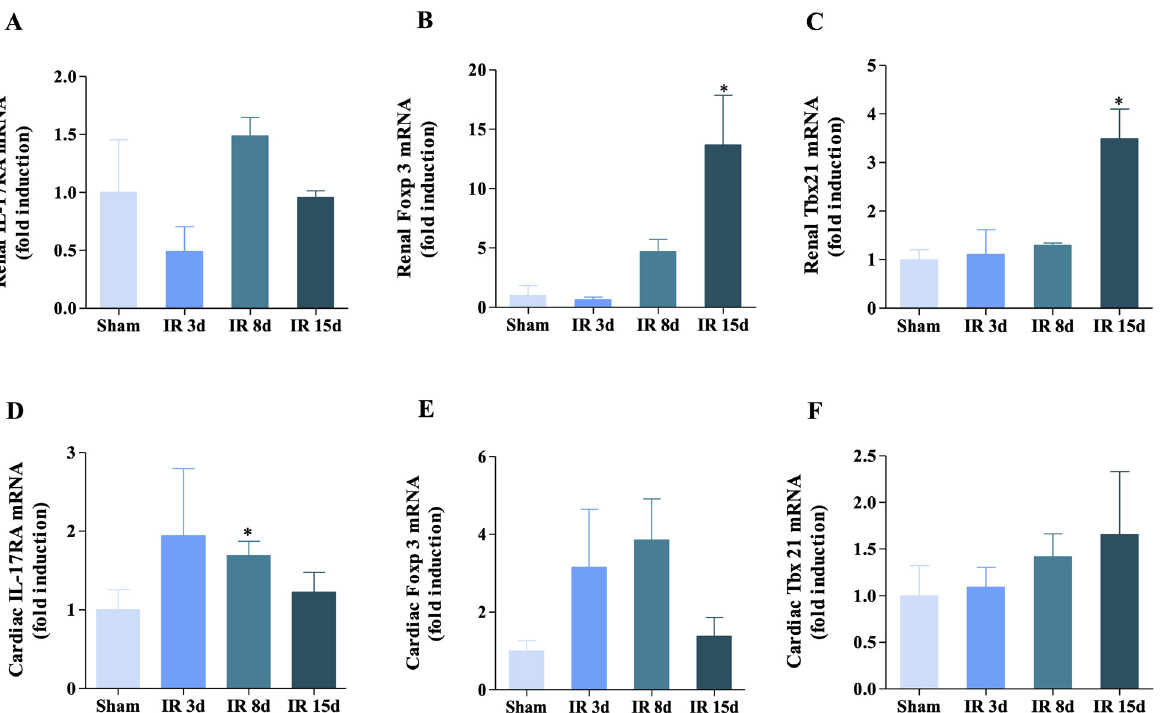
Figure 4. Gene expression of IL-17RA, Foxp3, and Tbx21 was modified for renal I/R in the renal and cardiac tissue. ( A ) IL-17RA mRNA level, ( B ) Foxp3 mRNA level, and ( C ) Tbx21 mRNA level in the left kidney. ( D ) IL-17RA mRNA level, ( E ) Foxp3 mRNA level, and ( F ) Tbx21 mRNA level in the heart. n = 4 for all groups evaluated in both kidney and heart. Data are expressed as mean ± SEM, and one-way ANOVA followed by Bonferroni’s post-hoc test were performed. * vs. sham p < 0.05.